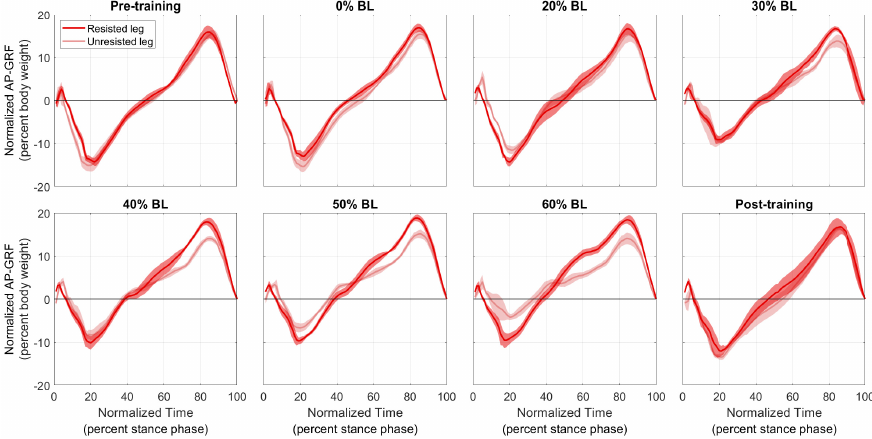
Figure 9. Normalized AP-GRFof the healthy participant. Test conditions are detailed in Table 1. Solid lines represent the normalized mean, and shaded regions represent the standard deviation for each normalized time